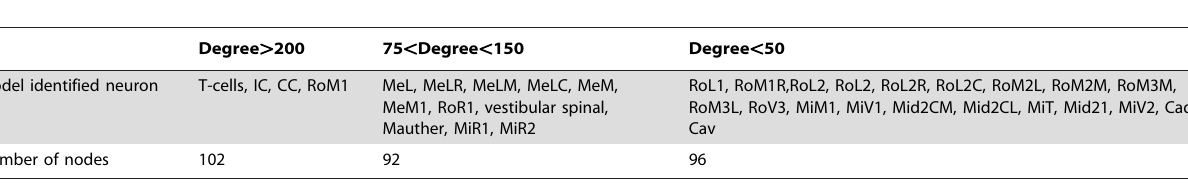
Table 3. Distribution of degrees among identified descending neuron types in the zebrafish model.